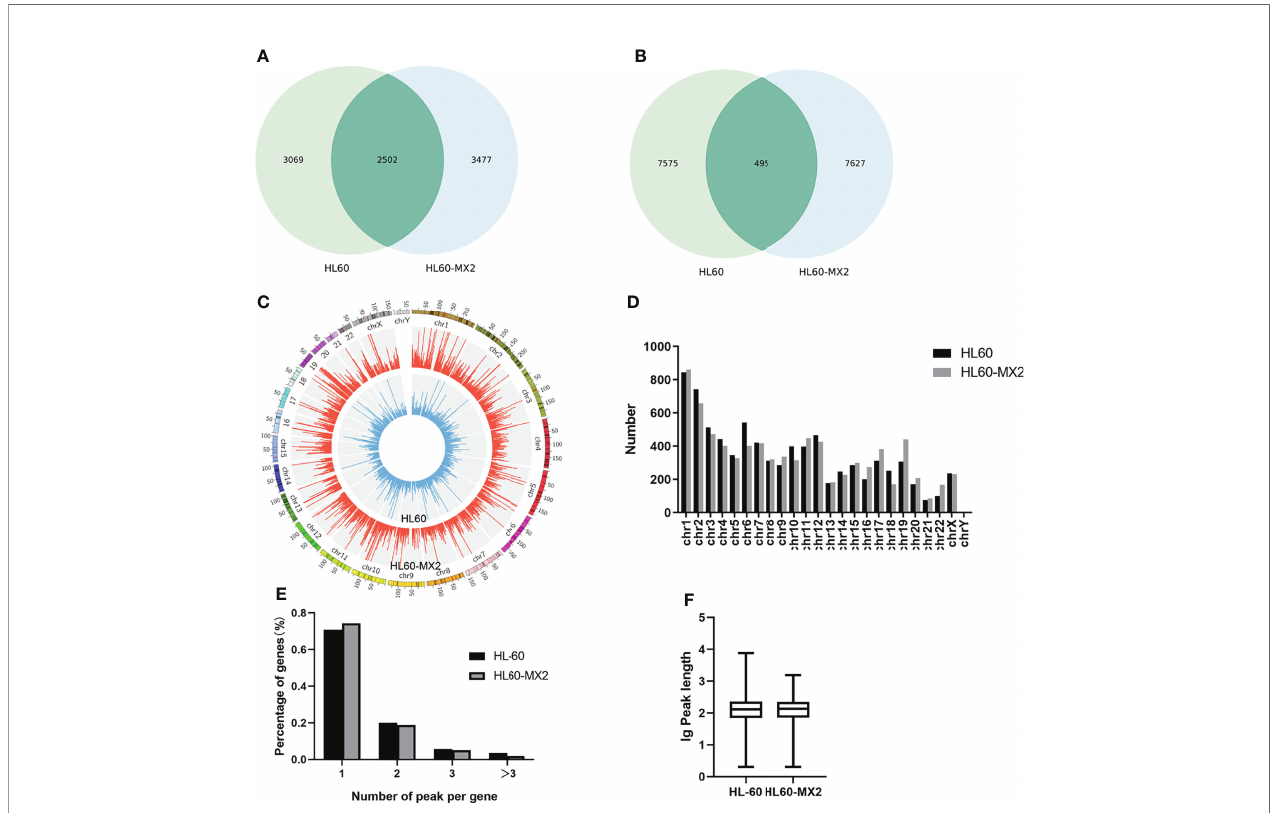
FIGURE 1 | Overview of m7G methylation in HL60 and HL60/MX2 cells. (A) Venn diagram of m7G genes in HL60 and HL60/MX2 cells. (B) Venn diagram of m7G peaks in HL60 and HL60/MX2 cells. (C) Visualization of m7G at the chromosome level in HL60 and HL60/MX2 cells. (D) The number of m7G peaks in HL60 and HL60/MX2 cells on each chromosome. (E) The number of m7G peaks on each mRNA. (F) The length of the m7G methylation peaks in HL60 and HL60/MX2